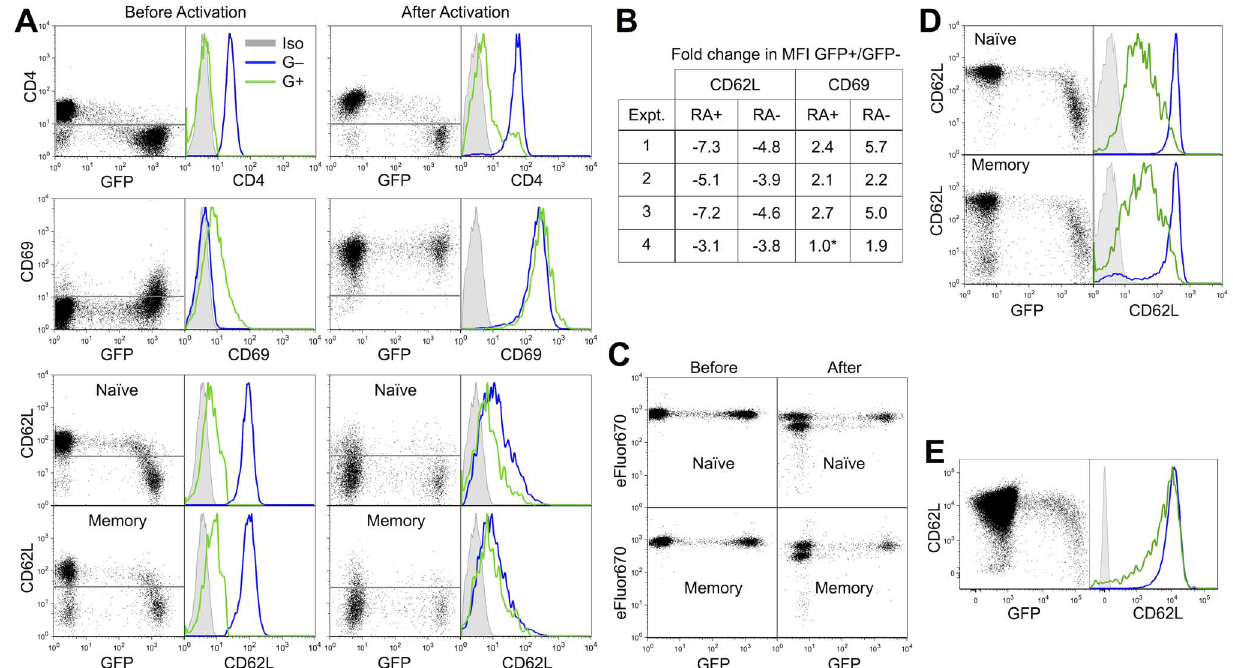
Figure 1. Down-modulation of CD62L and upregulation of CD69 and on productively infected naı¨ve and memory resting CD4 T cells. A. Resting IL-7 treated CD4 + T cells were infected with the GFP reporter virus NLENG1, restricted to a single round of infection by treatment with the protease inhibitor indinavir (2 m M). Flow analysis was carried out on day 5 post infection on cells with and without activation by a CD3/CD28 beads on day 3 p.i. Grey: isotype-matched IgG control antibody staining. Blue: GFP-negative cells. Green: GFP + cells. Data are representative of 4 independent experiments. B. Fold change in CD62L and CD69 expression on naı¨ve and memory CD4 + resting T cells in A. With on exception (*) all values were statistically different (p , 0.01) from the negative control by a T(x) population comparison test [134]. C. Failure of GFP + cells proliferate demonstrates that CD62L-low cells are not produced by preferential expansion of an existing CD62L-low population. Experiment shown is representative of . 5 similar experiments. D. IL-4 supports HIV-1-induced down-modulation of CD62L on both naı¨ve and memory resting CD4 + T cells. Experiment shown is representative of . 3 similar experiments. E. CD62L down-modulation on HIV-1 infected naı¨ve tonsil T cells 7 days after infection. Similar results were observed on CD45R0 + cells (not shown). Experiment shown is representative of 2 similar